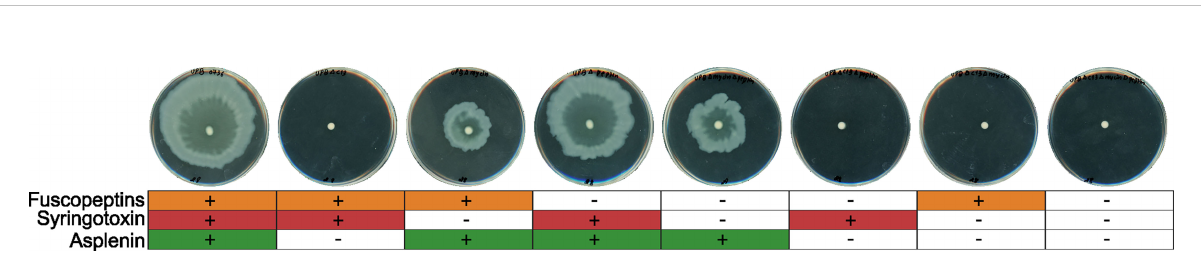
FIGURE 2 Swarming motility in P. fuscovaginae UPB0736 and CLP mutants. Soft agar LB plates were inoculated with an overnight culture of P. fuscovaginae UPB0736 or its CLP mutants. The plates were incubated at 28°C and assessed after 24 hours of growth. The experiment was conducted twice, in triplicate, with comparable output. The table below the plates refers to the phenotypes of WT and CLP mutants, as indicated in Table